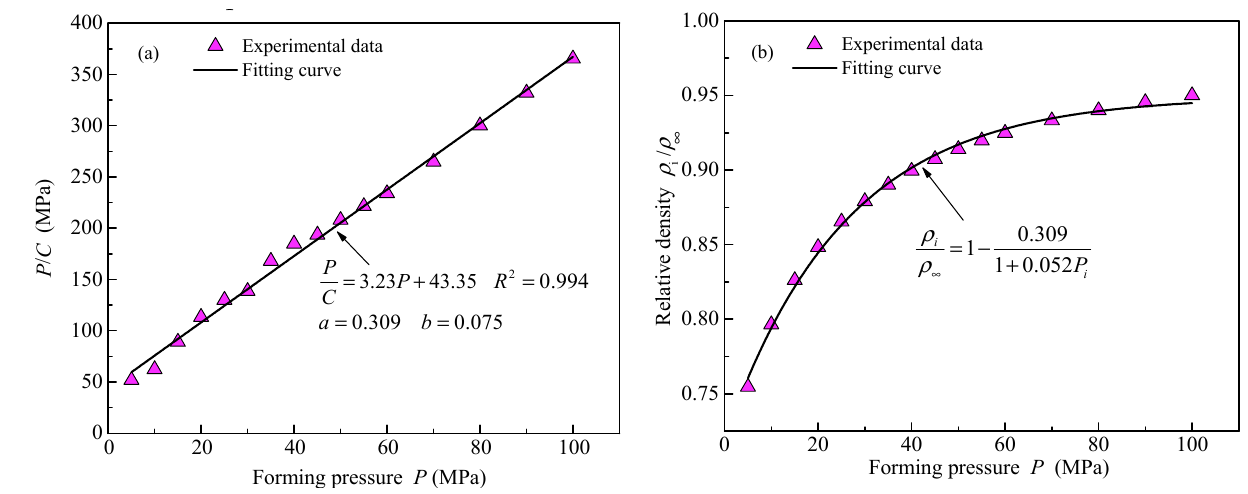
Figure 4. Kawakita curve and relative density change during compression. ( a ) P / C ; ( b ) ρ i / ρ